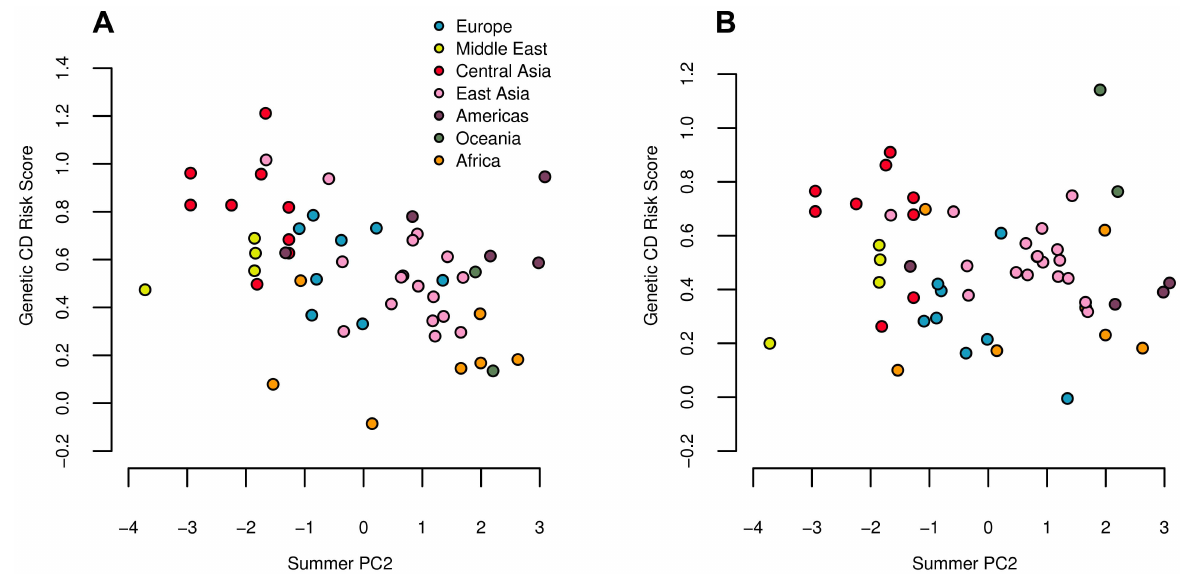
Figure 7. Estimated genetic risk score for Crohn’s disease (A) and ulcerative colitis (B) risk plotted against summer PC2. Both correlations are significant against the genome wide background after controlling for population structure (Table 2). Since a large proportion of SNPs underlying these traits are shared, we note that these results are not independent.